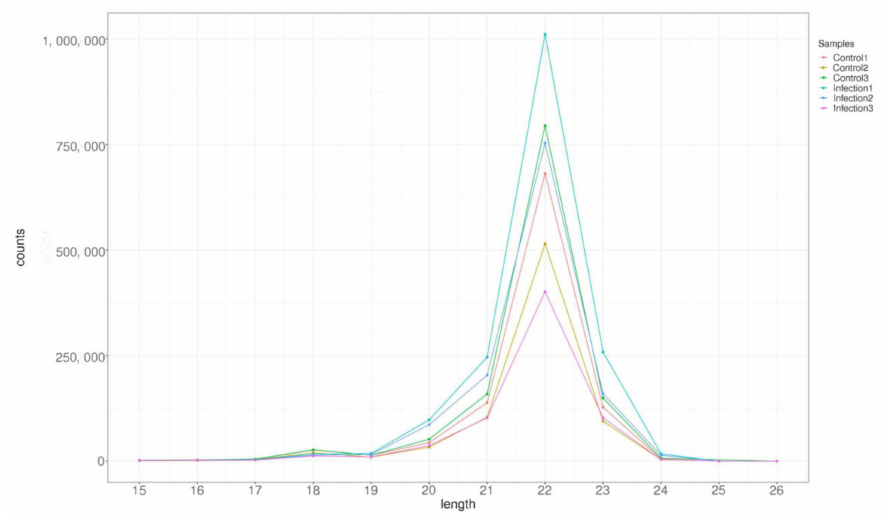
Figure 2. Clean read length distribution on each sequence. The x-axis represents the read length. The y-axis represents the percentage of each read